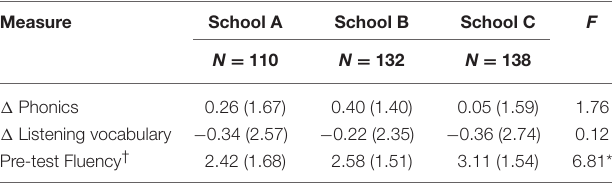
TABLE 4 | Averages obtained for District 1 5th-graders, separated by measure and school.